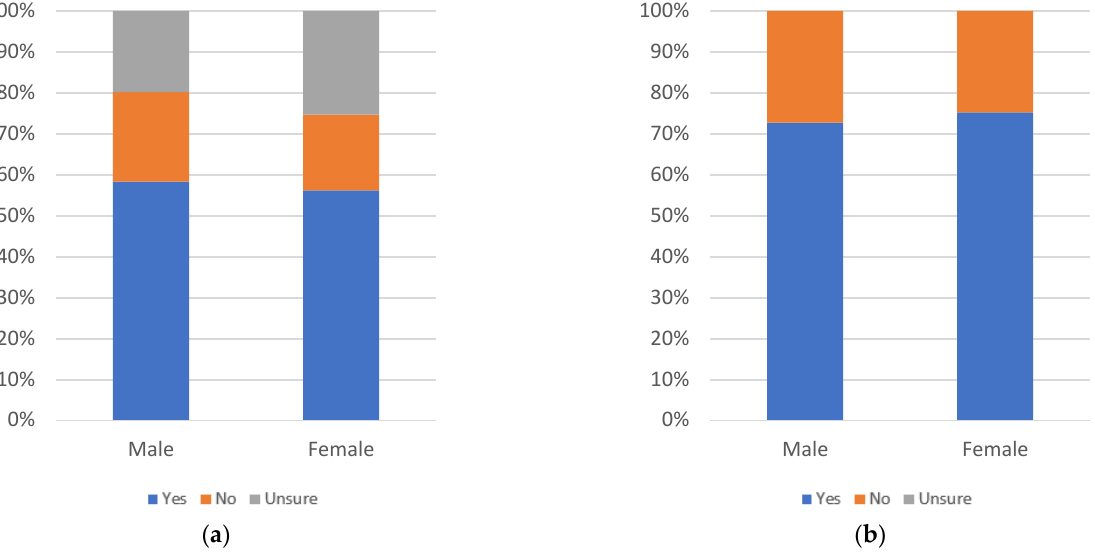
Figure 64. Label others’ use, by gender: ( a ) with uncertain respondents (left) and ( b ) without uncertain respondents (right).